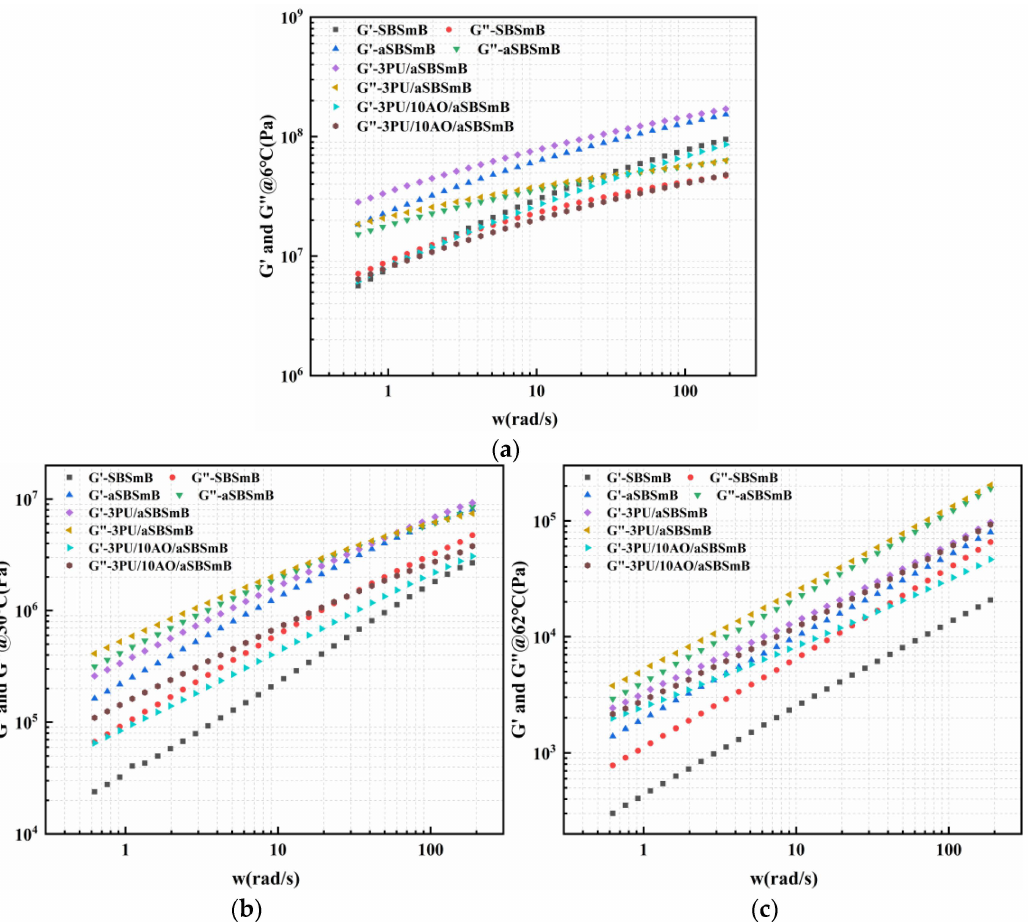
Figure 11. Frequency response to viscoelastic transition of reaction-rejuvenated SBSmB at various temperatures: ( a ) low temperature, 6 ◦ C; ( b ) medium temperature, 30 ◦ C; ( c ) high temperature, 62 ◦